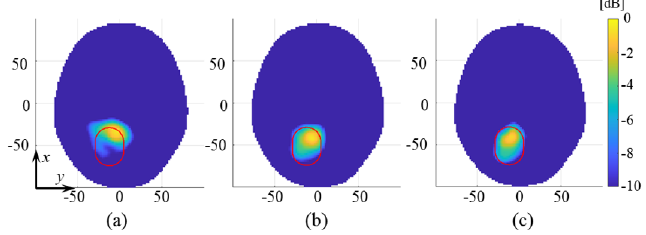
Figure 17. ICH-HP_I amplitude values of the normalized reconstructed dielectric contrast obtained with noiseless simulations and varying the threshold on the singular values: ( a ) − 21 dB, ( b ) − 30 dB, and ( c ) − 40